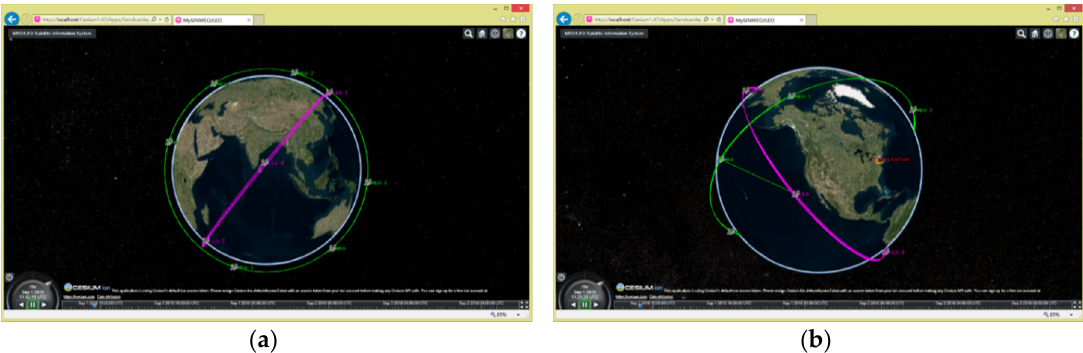
Figure 13. The 3D view display of the MEO/LEO satellite information system: ( a ) The satellite layout and the specific distribution of the MEO constellation; ( b ) the MEO satellite and LEO satellite are transmitting data.